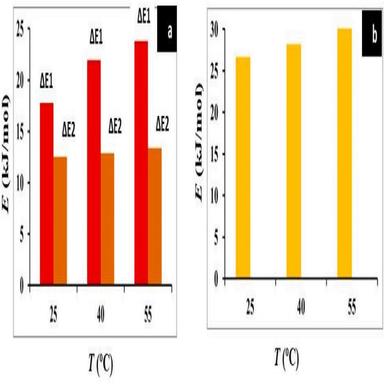
Adsorption energies for (a) MO dye and (b) Cr(VI) adsorption on Mus/St/MNPs composite.